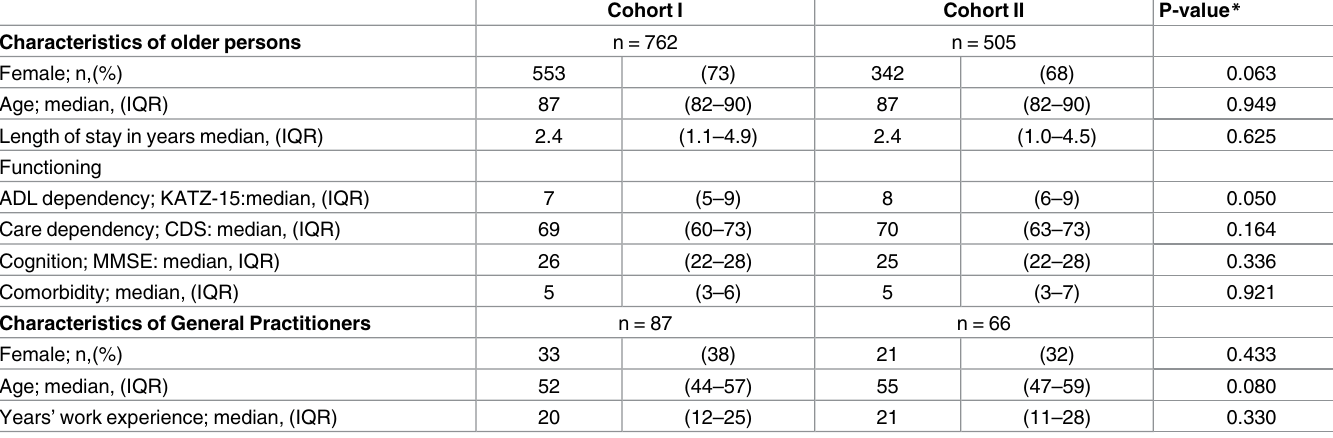
Table 1. Characteristics of participating older persons having had at least one contact with a General Practitioner in the preceding 12 months and participating General Practitioners.